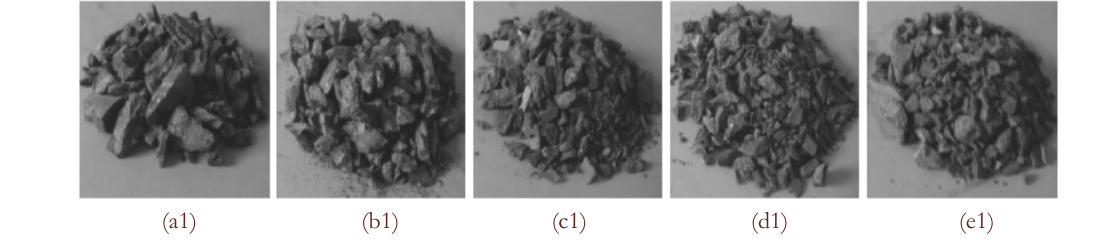
Figure 1: Damage form of concrete